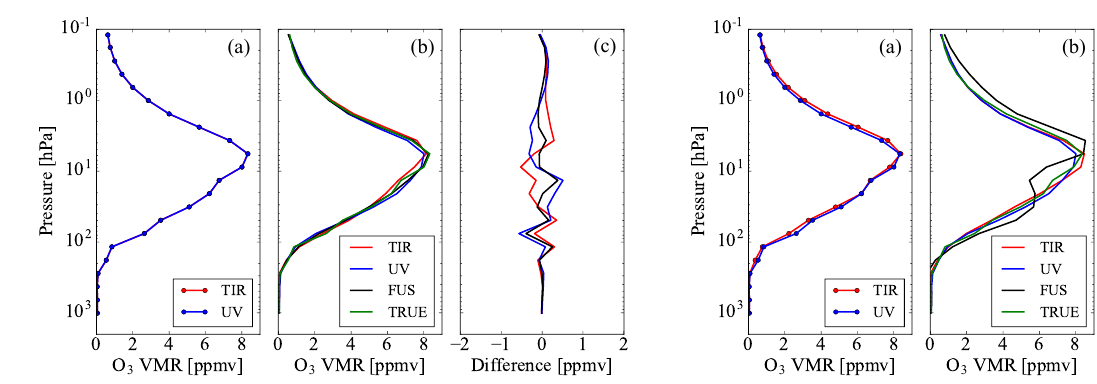
Figure 3. As Fig. 1 but for case